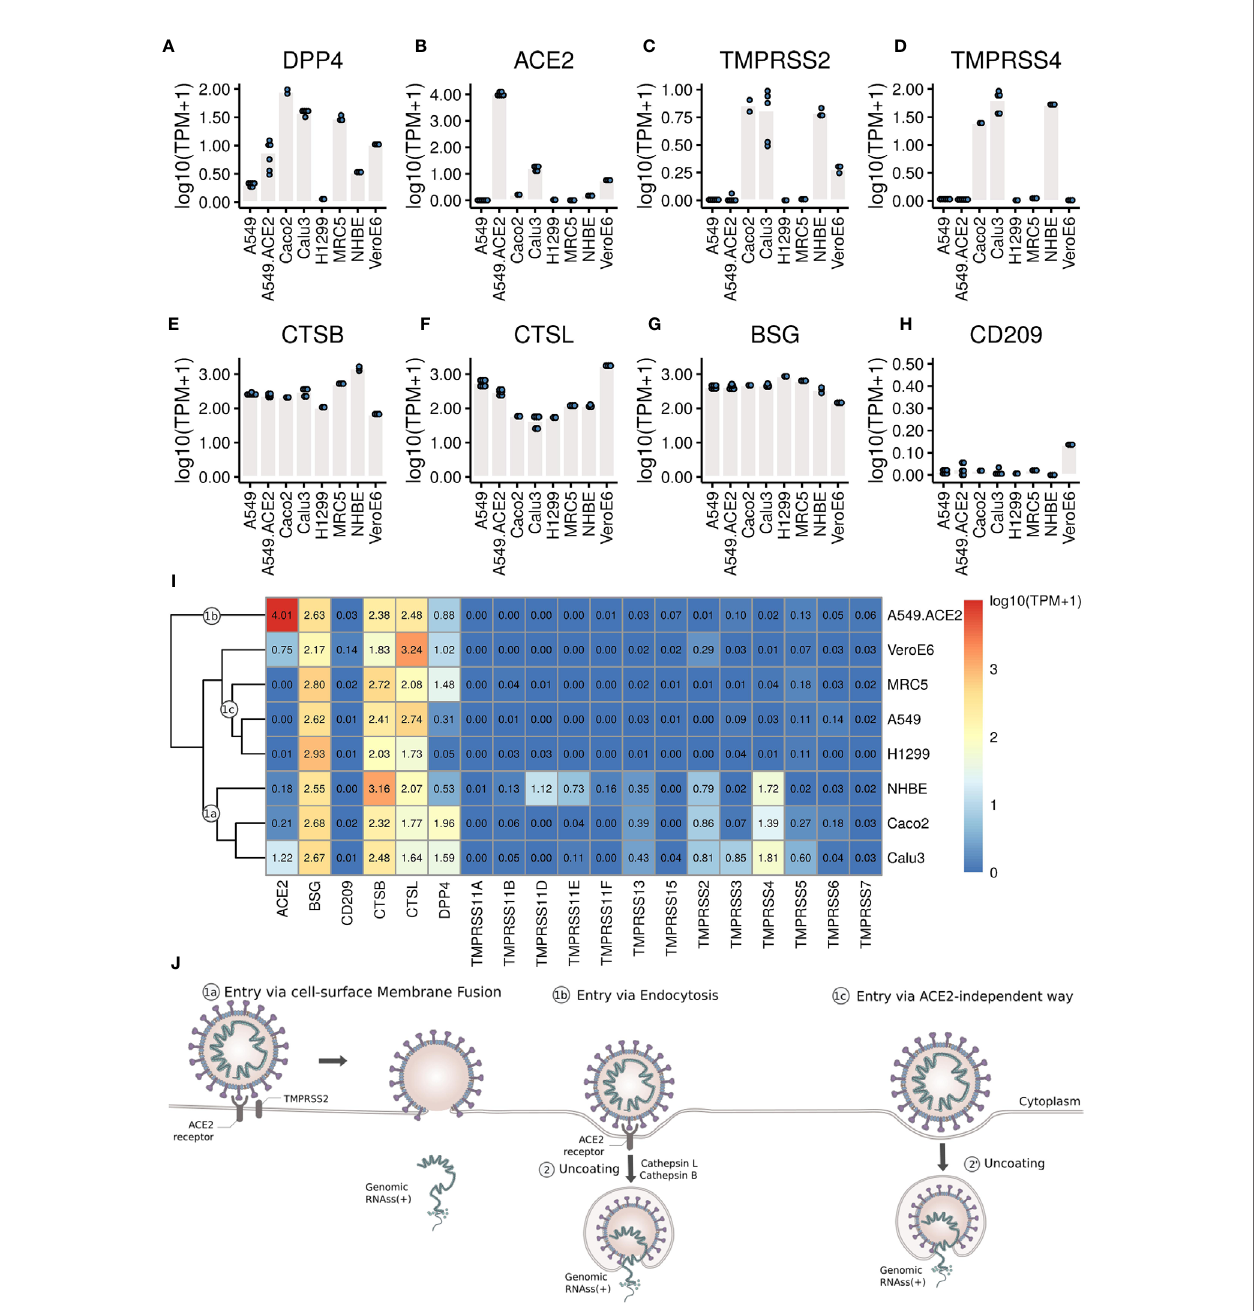
FIGURE 3 | The expression levels of the receptors and proteases. (A – H) Each dot represents the expression value in each sample. (I) Heatmap of the expression levels of coronavirus associated receptors and factors of different cell types. Labels 1a, 1b, 1c mark cell clusters that likely share entry routes sketched in (J) . (J) Entry mechanisms involved in SARS-CoV-2 entry into cells. Schematic is based on a fi gure by Vega Asensio - Own work, CC BY-SA 4.0, https://commons.